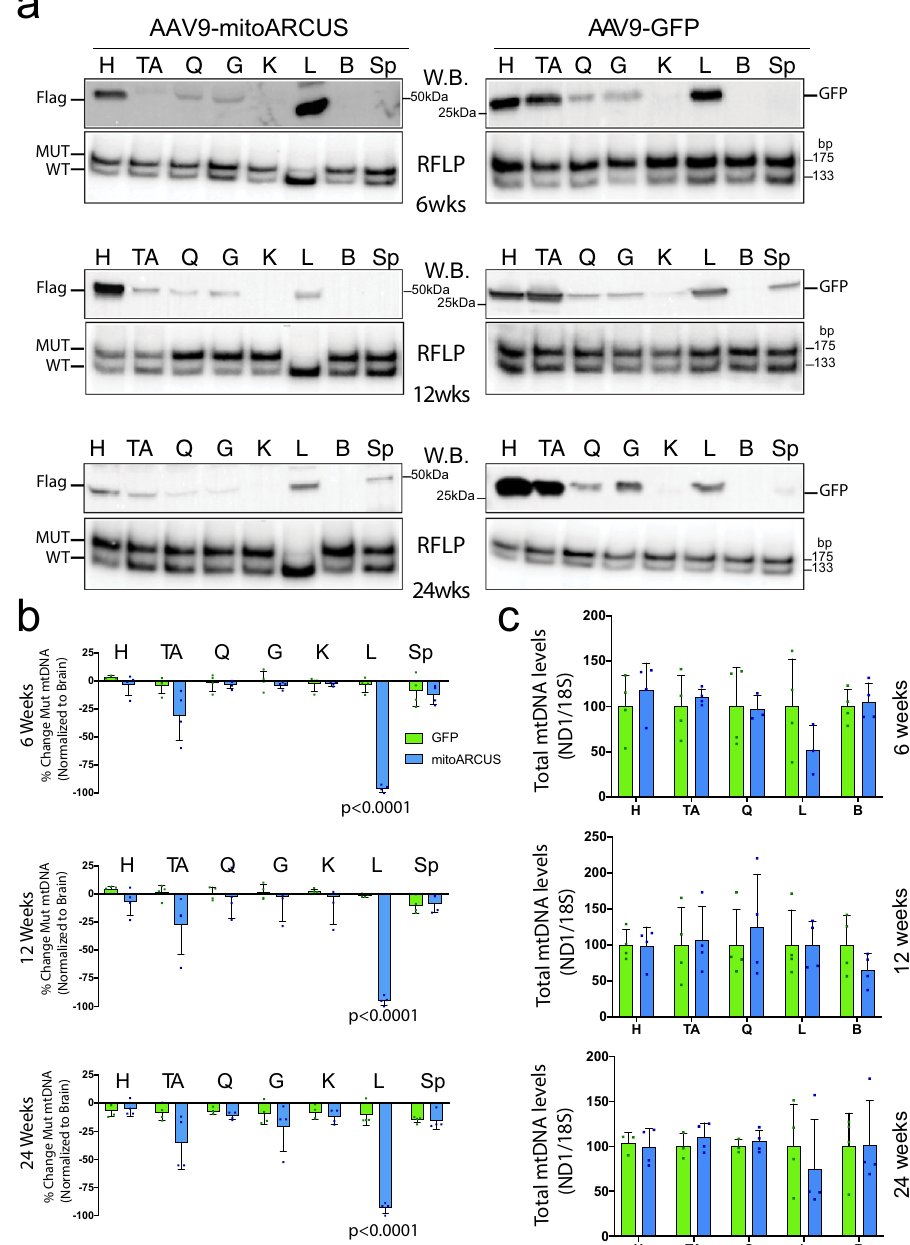
Fig. 4 AAV9-mitoARCUS effect in treated adult mice. a Representative western blottings (W.B.) of homogenates (top panels) with Flag antibody for AAV9-mitoARCUS samples and GFP antibody for AAV-GFP samples. RFLP “ last-cycle hot ” PCR analysis (RFLP, bottom panels) of DNA samples from the same injected animals, at 6, 12, and 24 weeks PI. Similar analyses were performed for each animal. b Quanti fi cation of heteroplasmy shift shown as percent change in heteroplasmy across all tissues at 6, 12, and 24 weeks PI normalized to brain tissue. Heteroplasmy of the heart (H), tibialis anterior (TA), quadriceps (Q), gastrocnemius (G), kidney (K), liver (L), and spleen (Sp) were compared to that of the brain (negative for expression of mitoARCUS). c Quanti fi cation by qPCR of total mtDNA levels were measured in the heart, skeletal muscle, liver, and brain (B) at 6 and 24 weeks PI using ND1 and ND5 mitochondrial primer/probes normalized to 18S (nuclear DNA). Data are mean ± SEM of n = 4. Statistical analysis was performed using two-tailed Student ’ s t